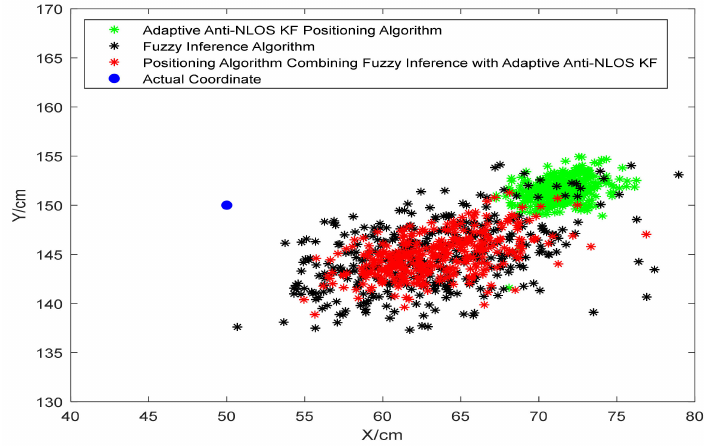
Figure 7. Scatter diagram of static positioning by three positioning